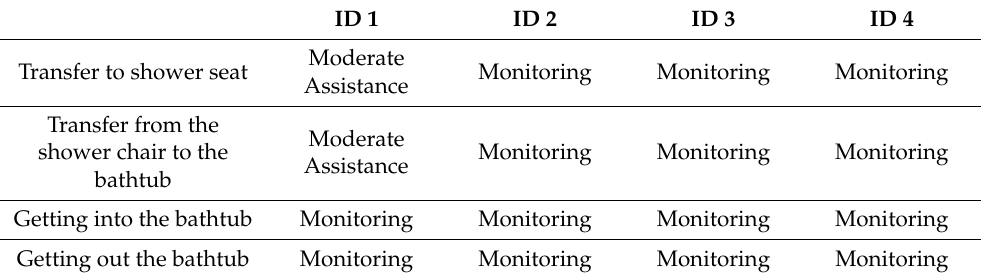
Table 3. The care requirements for bathing activities using